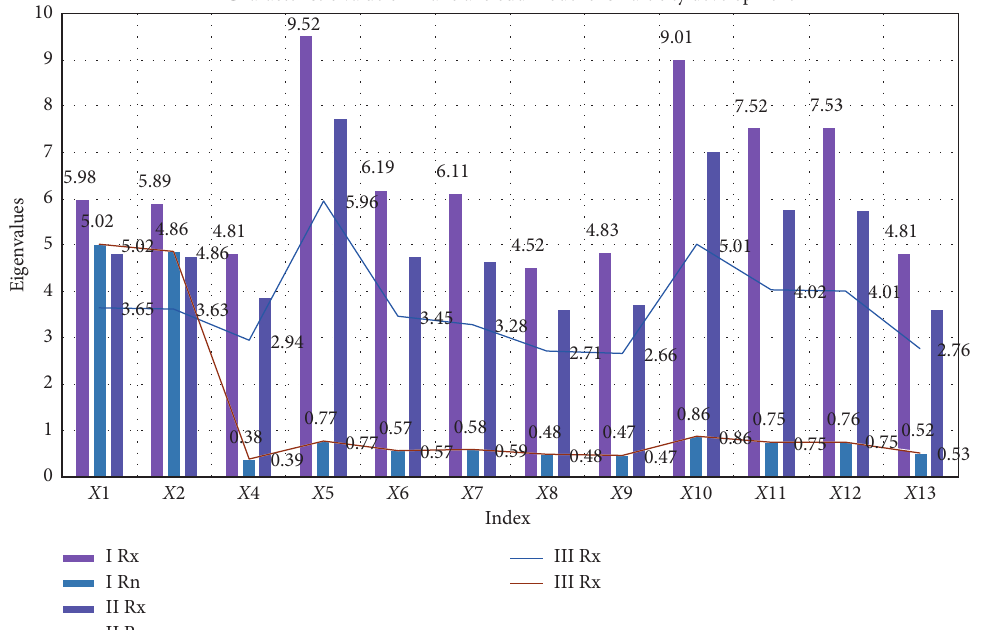
Figure 2: Characteristic value of the financial cloud model of smart city development level.